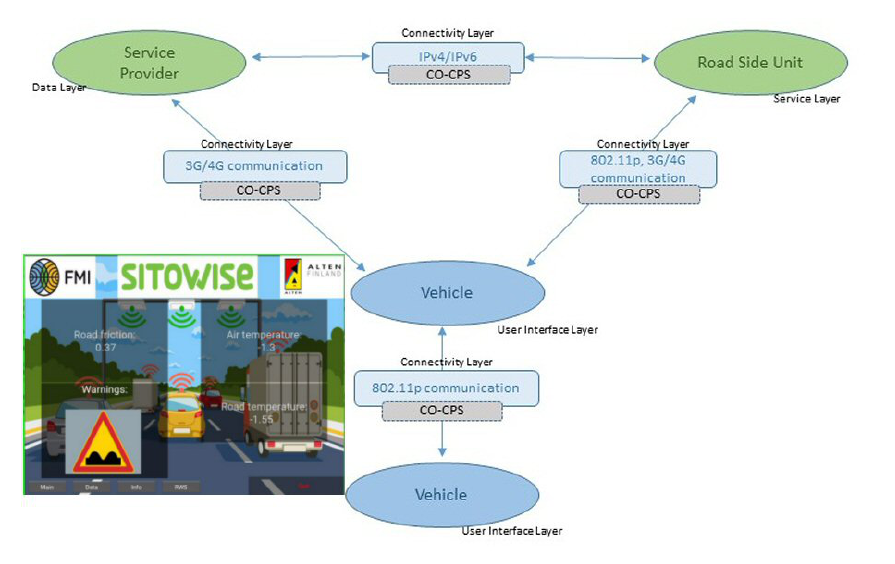
Figure 4. Operational structure of the use case “Vehicles and Roadside Unit (RSU) interaction” with communication to the cloud using 3G/4G, and IEEE 802.11p and 3G/4G for communication between vehicles and roadside